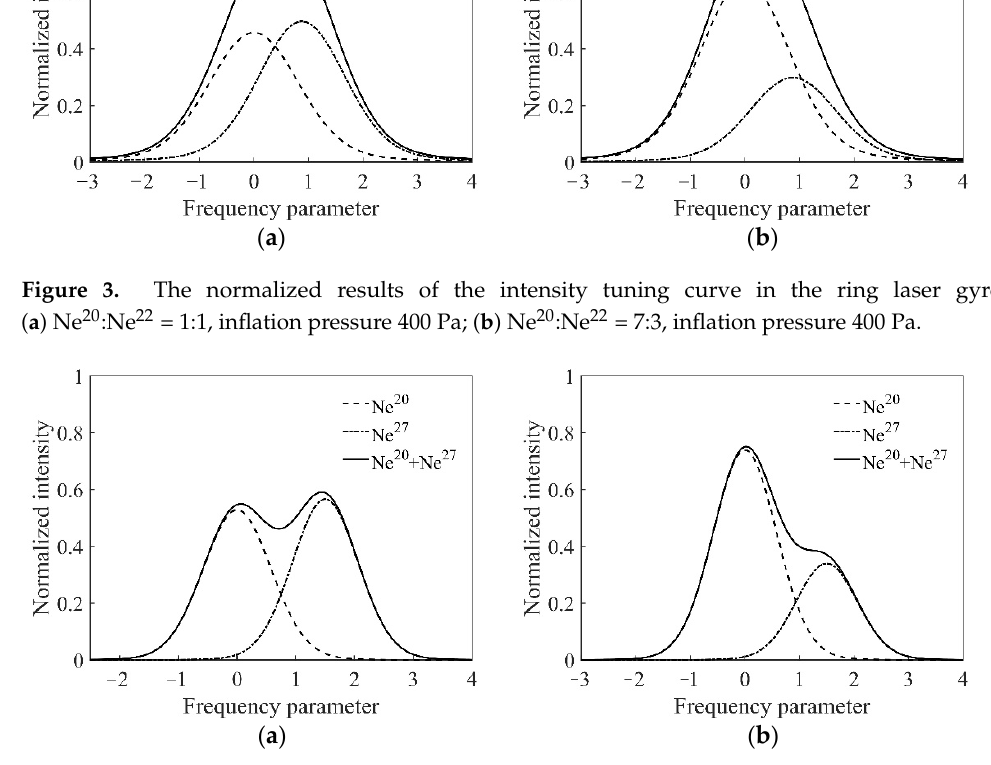
Figure 4. The normalized results of the intensity tuning curve in the ring laser gyro. ( a ) Ne 20 :Ne 27 = 1:1, inflation pressure 400 Pa; ( b ) Ne 20 :Ne 27 = 7:3, inflation pressure 400